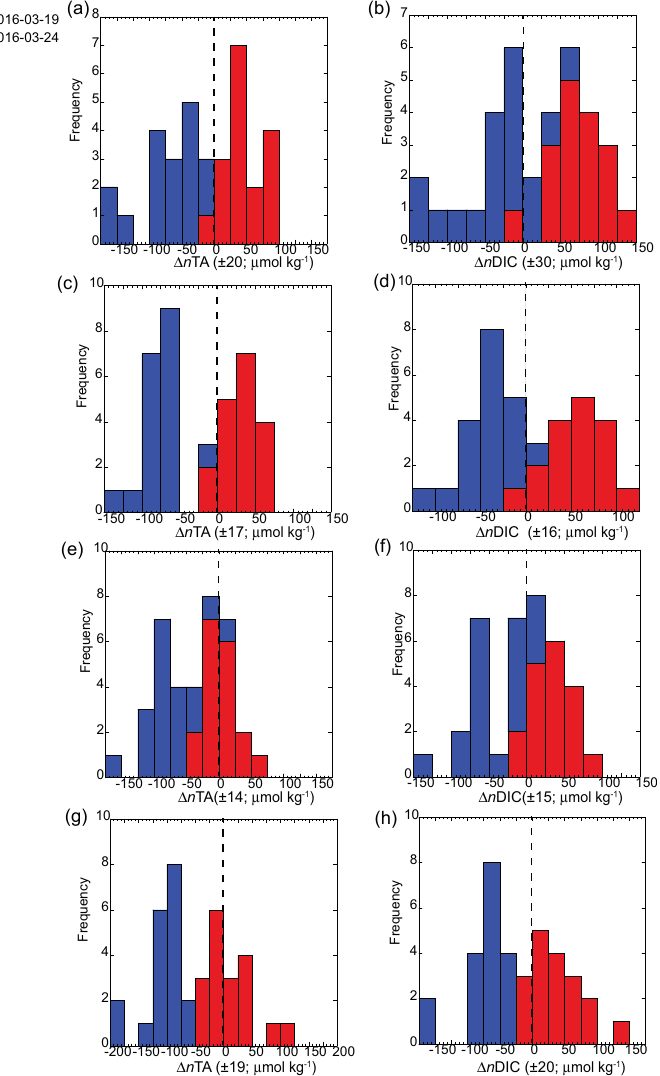
Figure 4. Histograms of (cid:49)n TA and (cid:49)n DIC capturing deficits and surpluses of n TA and n DIC with respect to open-ocean conditions. Overall, a transition from CaCO 3 production to CaCO 3 dissolution and photosynthesis to respiration occurred between the first (16 to 19 March 2016; blue) and second (21 to 24 March 2016; red) sampling periods for the shallow sampling sites (a–b) S1 and (c–d) S2, and the two deeper sites (e–f) S3 and (g–h) S4. Statistical ( p = 0 . 05) deficit and surplus values ( ± ) for (cid:49)n TA and (cid:49)n TA are shown in